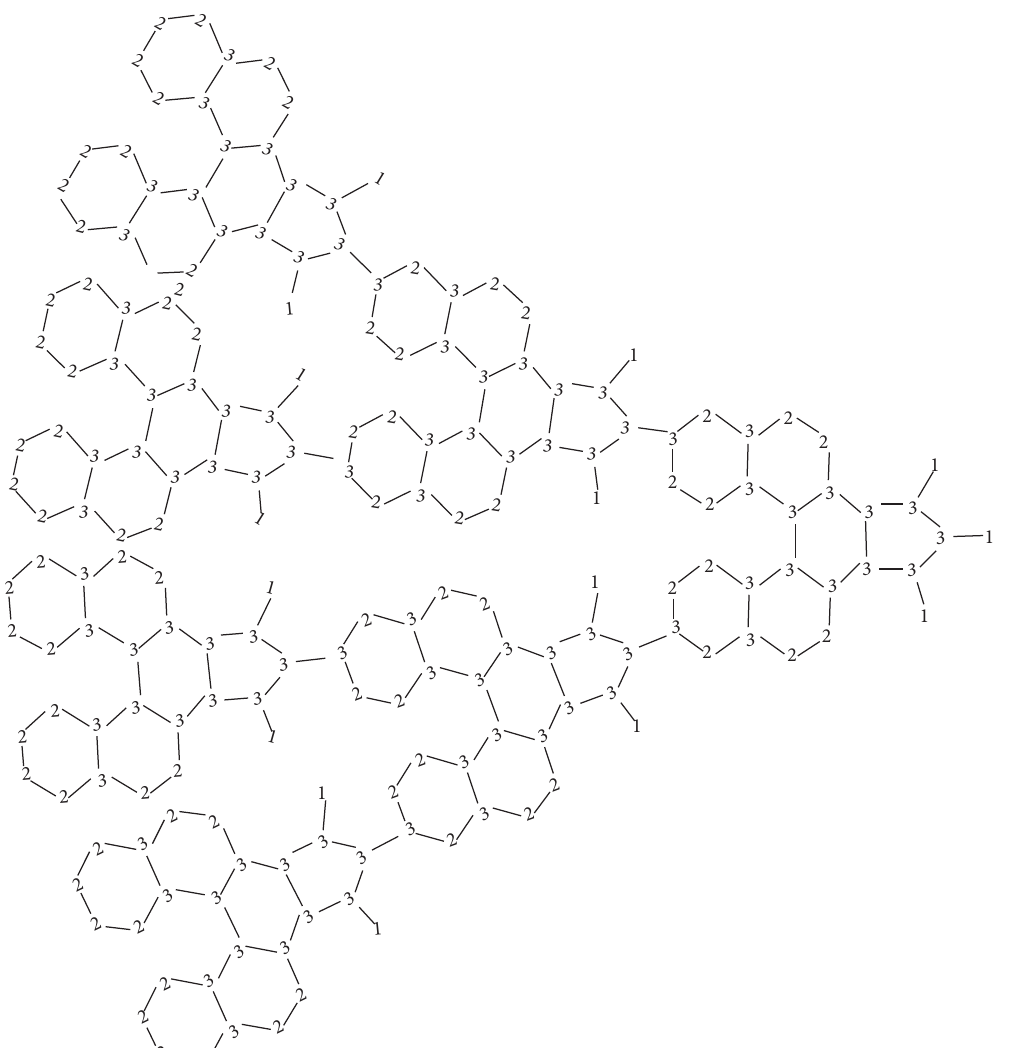
Figure 12: D [ 3 ] along with the degree of each 2